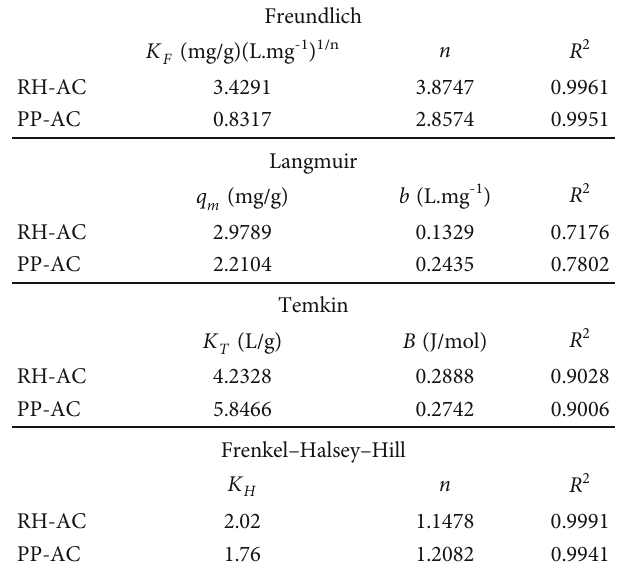
Figure 5: The (a) Langmuir, (b) Freundlich, (c) Temkin, and (d) Frenkel – Halsey – Hill for RH-AC and PP-AC, respectively. Table 1: The Langmuir, Freundlich, Temkin, and isotherm model constants as well as correlation coe ffi cients for acetic acid